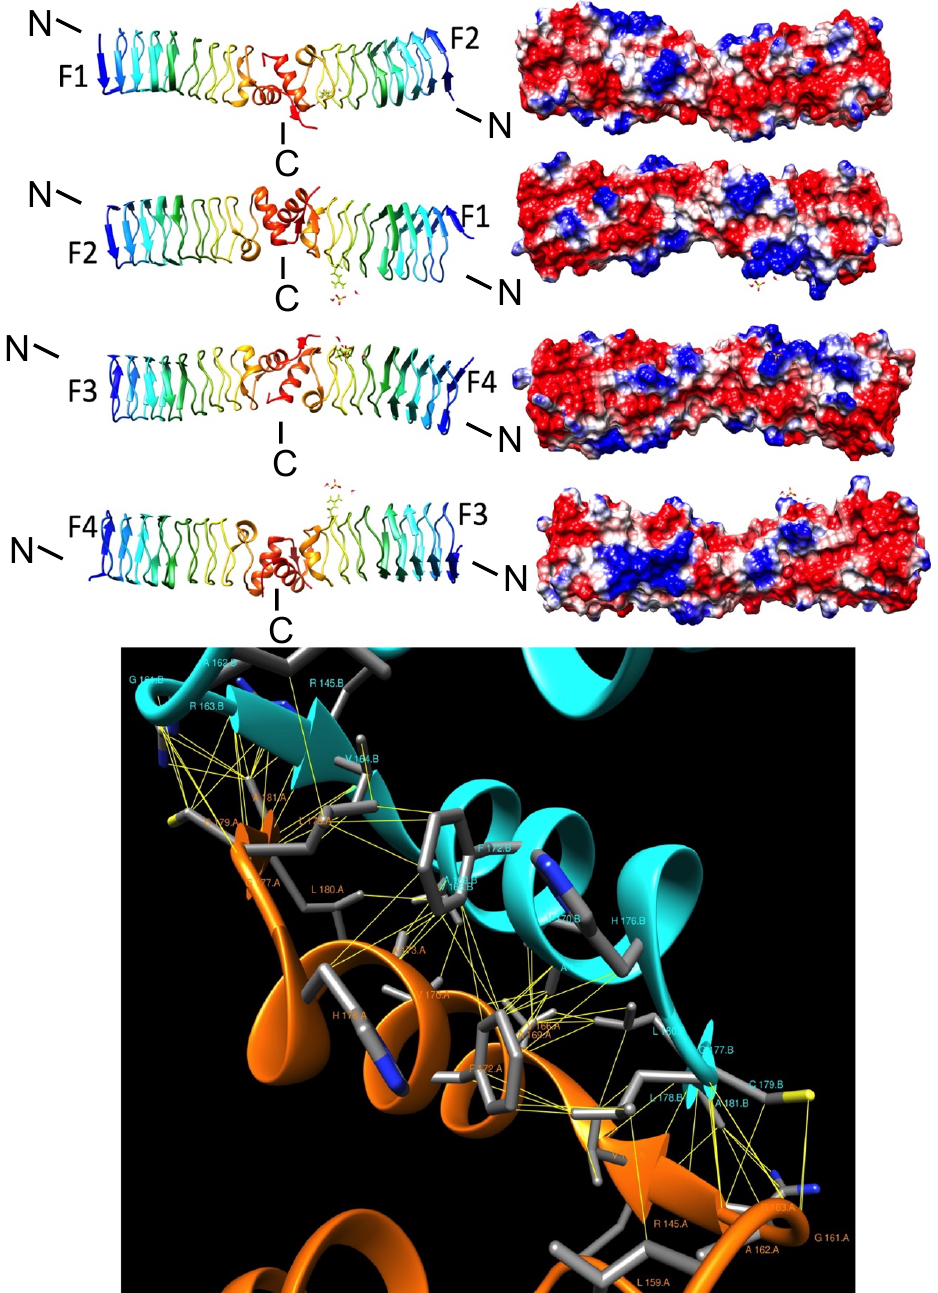
Figure 4. Structure and analysis of MfpA. The top panel (at left) shows the ribbon diagrams looking at the four different faces of the Rfr coil the structure and the corresponding electronic potential surface analysis (at right). The bottom panel shows the head-to-head dimer interface with non-bonded interactions depicted by yellow lines as identified using Intersurf [28] and depicted using Chimera [29]. Chain A is colored orange, Chain B is colored cyan, and interacting residues are